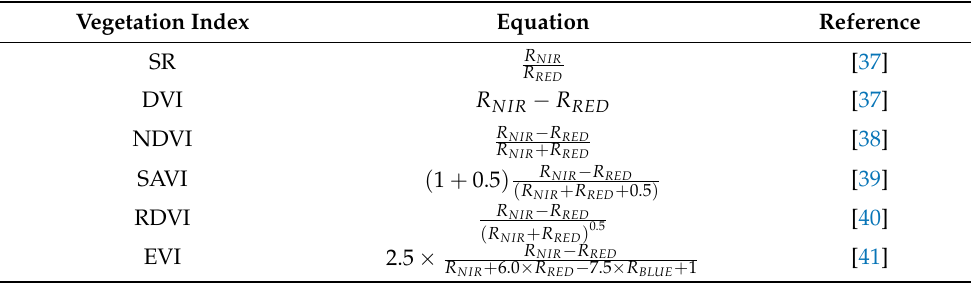
Table 1. Equations of vegetation indices. Vegetation